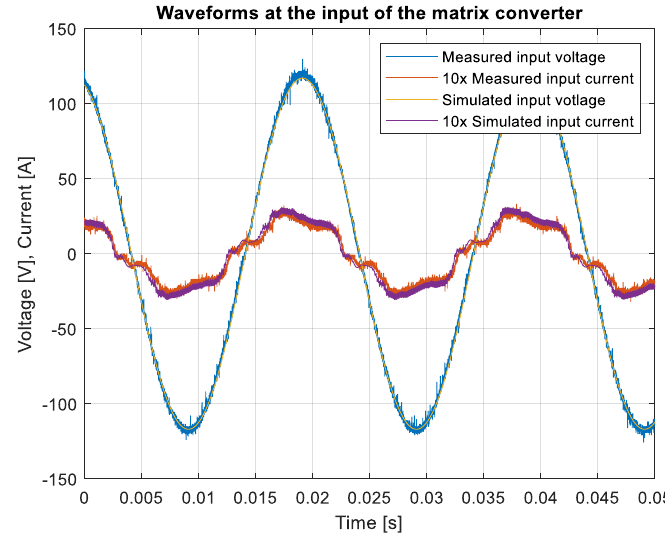
Figure 17. Comparison of the measured and simulated waveforms.